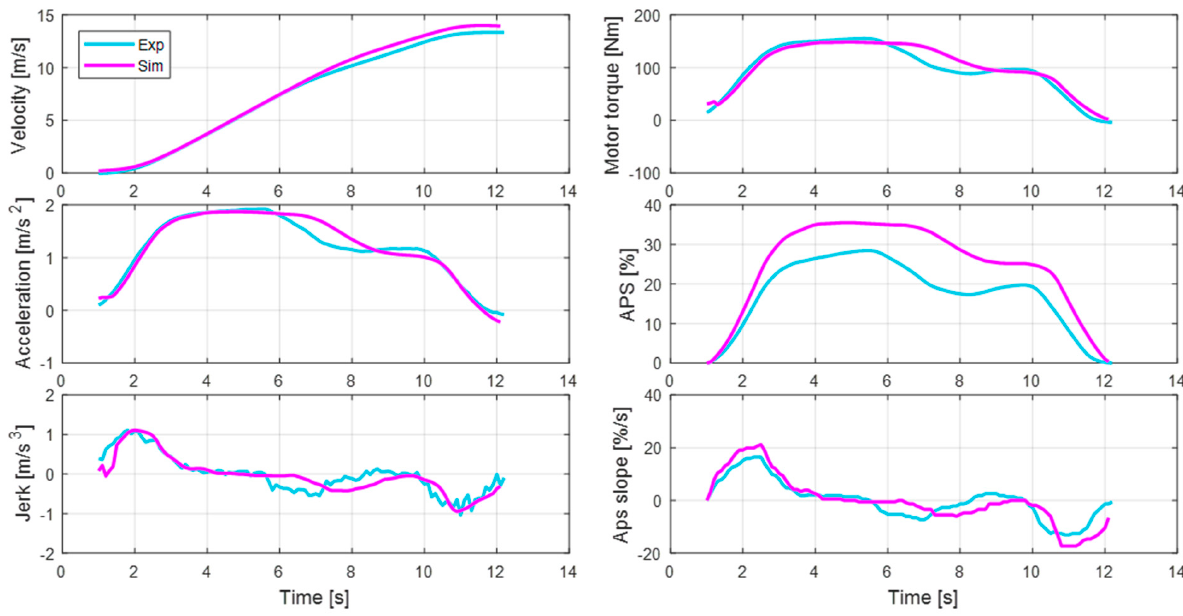
Figure 14. Comparison of the acceleration behavior between the experiments and simulations of the 1st driver.